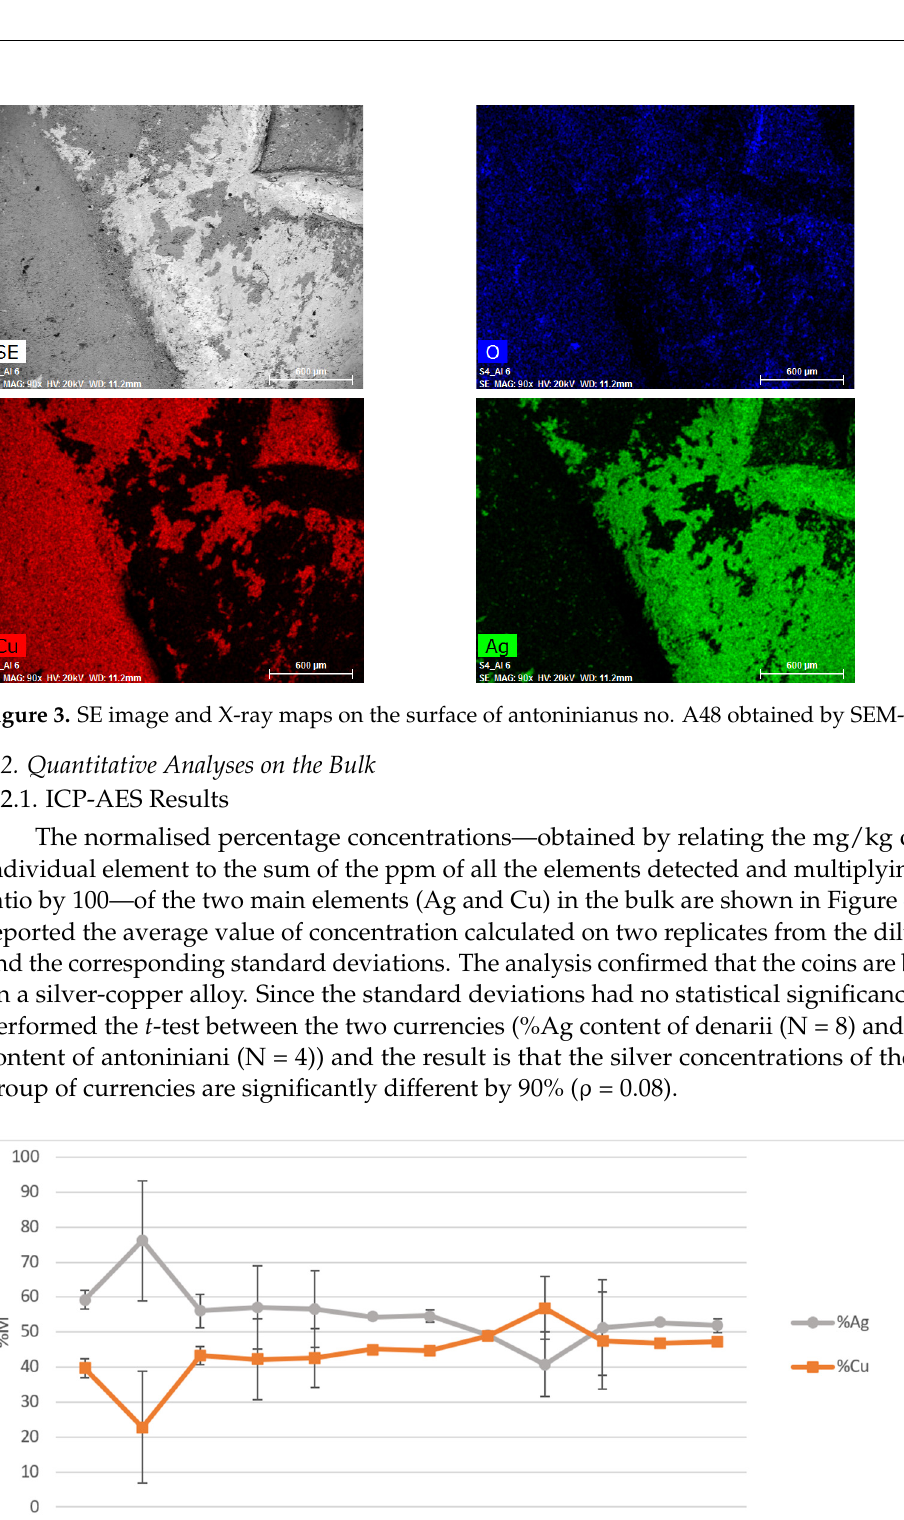
6 of 14 Figure 2. Average Ag/Cu ratio of the 160 coins analysed with respective error bars, denarii in blue and antoniniani in orange. The x-axis shows the emperors who issued the coins under study. The ratio reported in y-axis regards μ -EDXRF signals. 2.1.2. SEM-EDX Results The SEM-EDX investigation was carried out on four well-preserved coins—two de- narii (no. D31, D126) and two antoniniani (no. A48, A148)—in order to study the different distribution of elements on the coins’ surface. These samples were chosen because, for